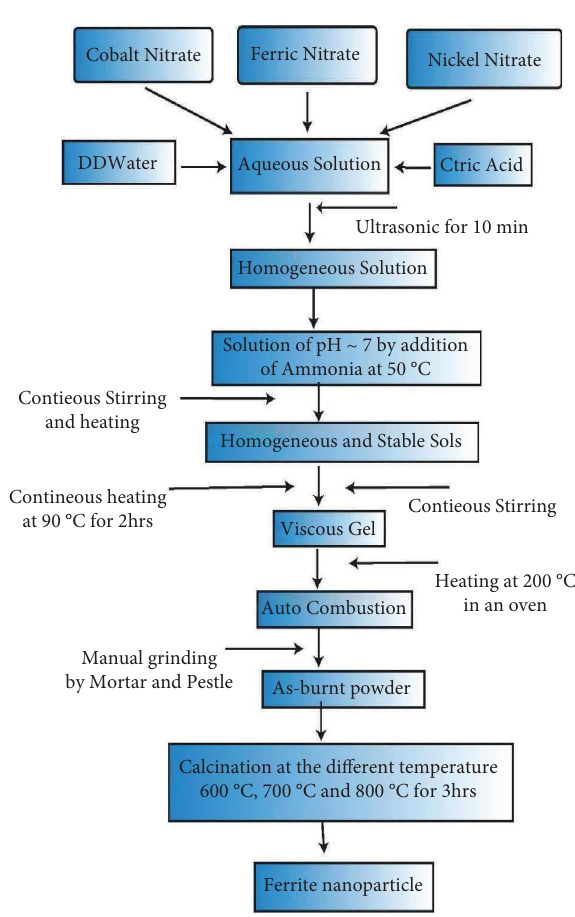
Figure 1: Schematic representation of the sol-gel